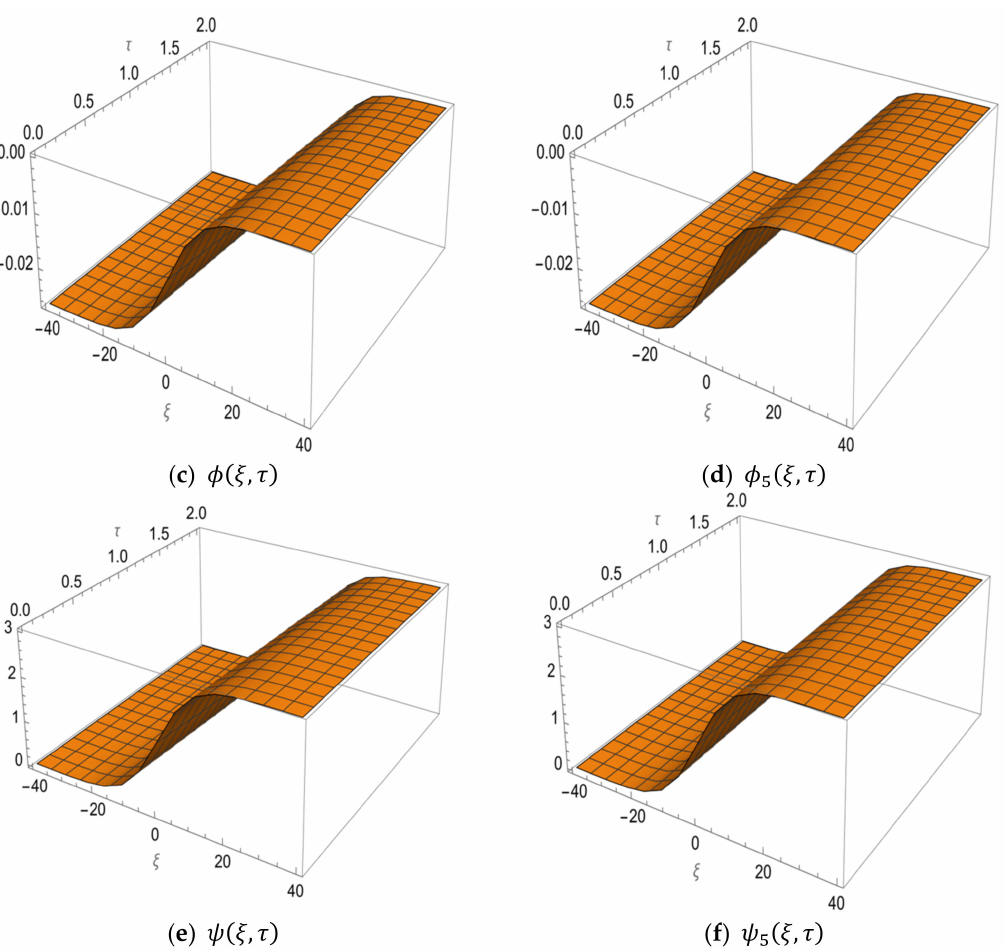
Figure 1. The exact solution and the fifth approximate LRPSM solution of HSC–KdV equations for the functions δ ( ξ , τ ) , φ ( ξ , τ ) , and ψ ( ξ , τ ) at τ ∈ [ 0,2 ] , ξ ∈ [ − 40,40 ] , and α = 1.